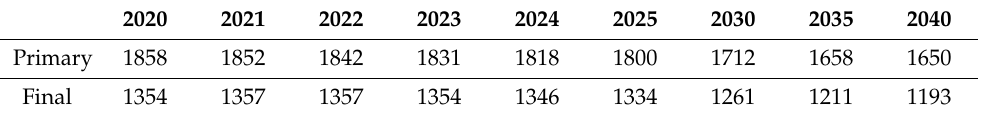
Table 1. Total primary and final energy consumption requirements for Europe in Mtoe unit [4].